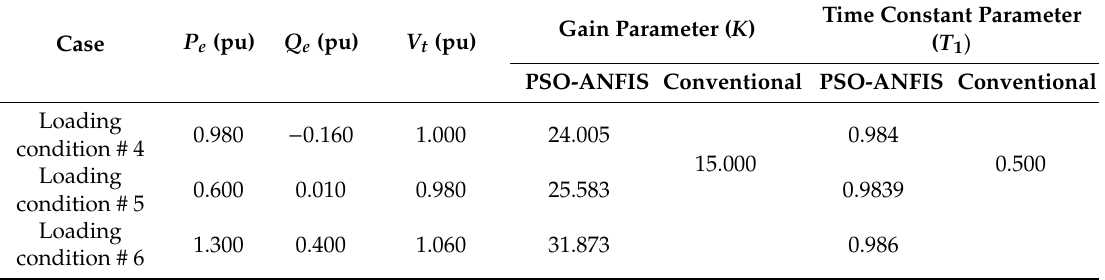
Table 10. Estimated PSS key parameters using the developed PSO-ANFIS models for three di ff erent operating situations (second network).